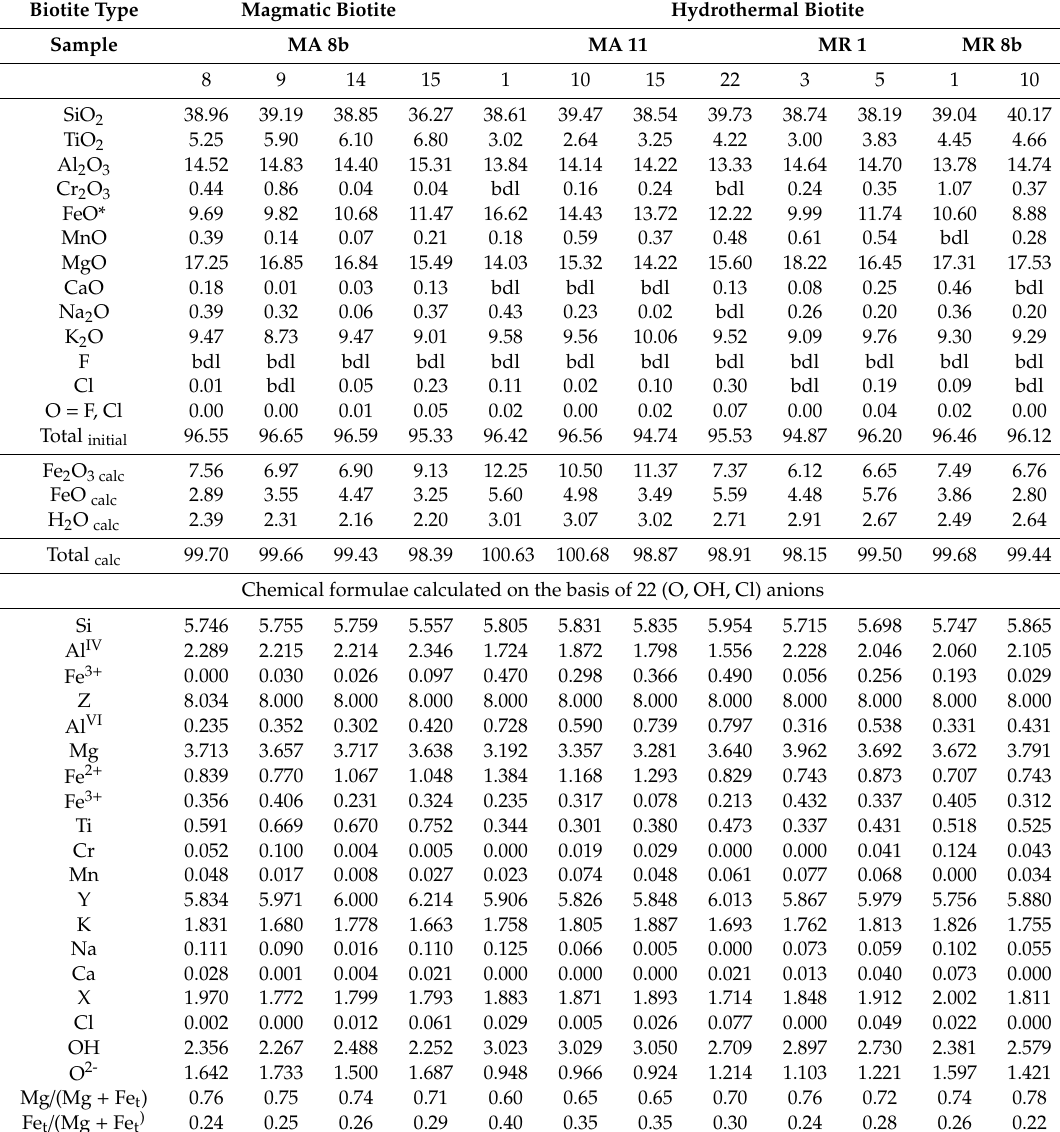
Table 2. Representative microanalyses (wt. %) and calculated formulae of magmatic biotite from